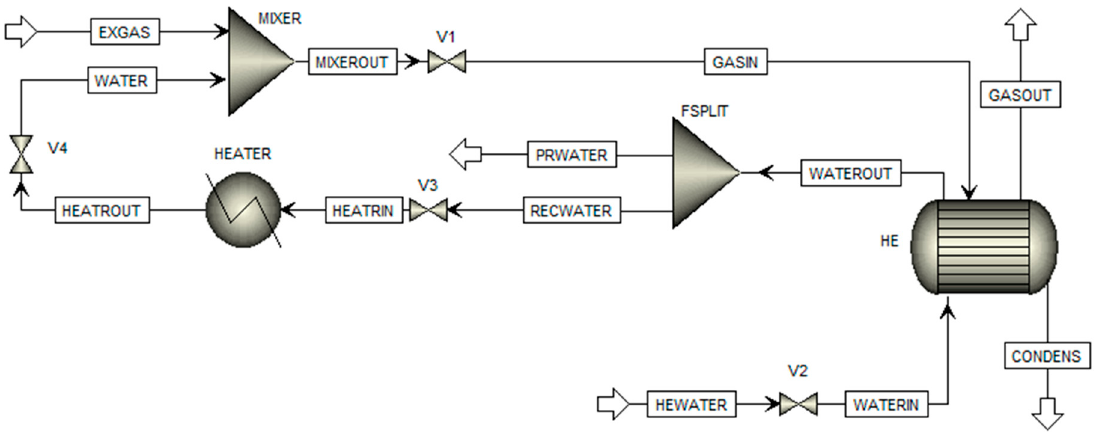
Figure 1. Flowsheet for the humidification of the flue gas using water.